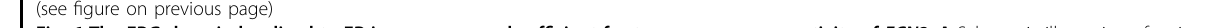
Fig. 6 The FBG domain localized to ER is necessary and suf fi cient for tumor suppressor activity of FCN3. A Schematic illustration of various FCN3 derivatives: wild type FCN3 , FBG domain, SP (signal peptide) + FBG domain, and FCN3 1-90. B Immunoblots showing ectopic expression of various FCN3 derivatives in A549 cells. Antibody against V5 epitope was used. ɑ – Tubulin was used as the loading control. C Expression and subcellular localization of FCN3 derivatives in A549 cells. Nuclear GFP expression indicates the virus-transduced cell. V5 staining shows localization of various FCN3 derivatives. Note no V5 staining in control virus (EV)-transduced cells and nuclear localization of FBG. D Colony formation assay after transducing with control virus or viruses expressing the indicated FCN3 derivatives in A549 cells. Note SP + FBG has growth inhibition effect. Numbers of colonies were counted and presented in bar graphs. Data are mean ± SEM of three independent experiments. E Apoptosis of A549 cells was evaluated with fl ow cytometry after transducing with control virus or viruses expressing the indicated FCN3 derivatives. (*) and (**) represent P - values of <0.05 and <0.01 from t tests,